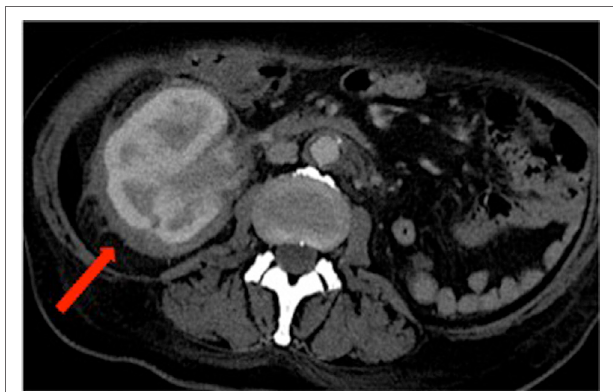
FIGURe 2 | Computed tomography scan of the abdomen revealing solid tissue surrounding the right kidney (commonly referred to as “hairy kidney”) [ red arrow ] and circumferential peri-aortic sheathing (“coated aorta”).